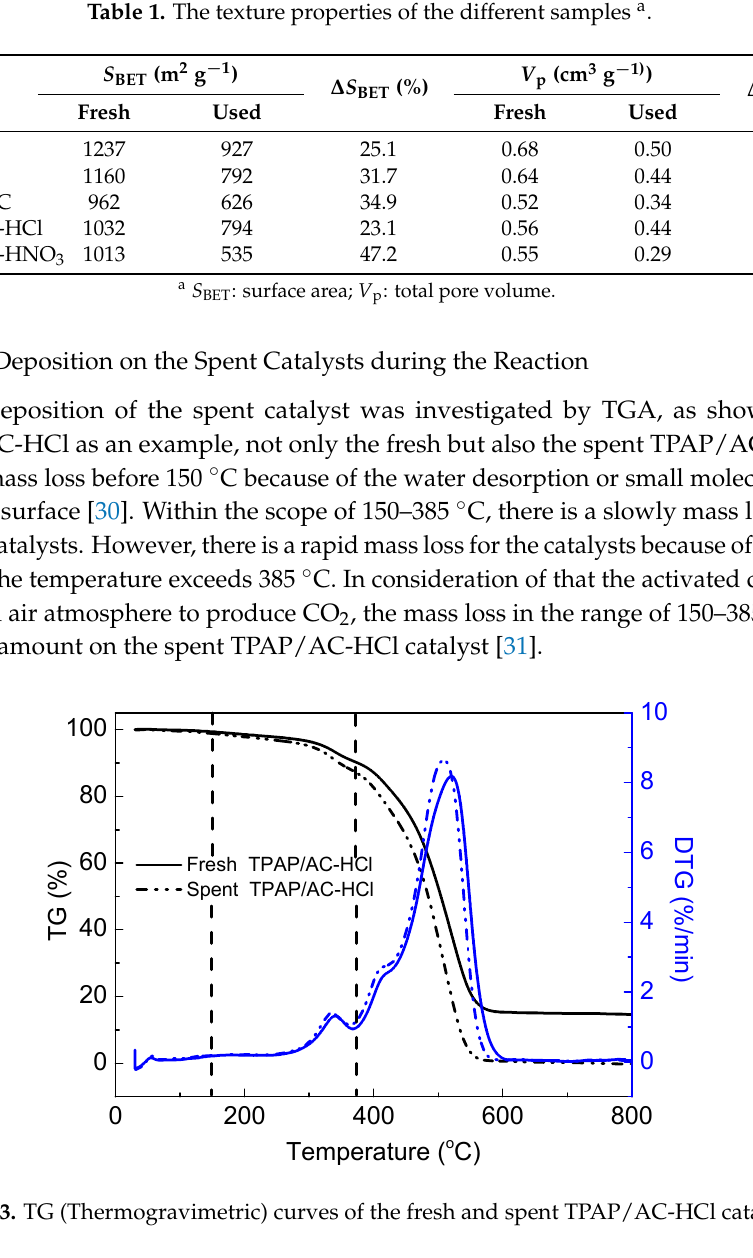
Table 1. The texture properties of the different samples a .